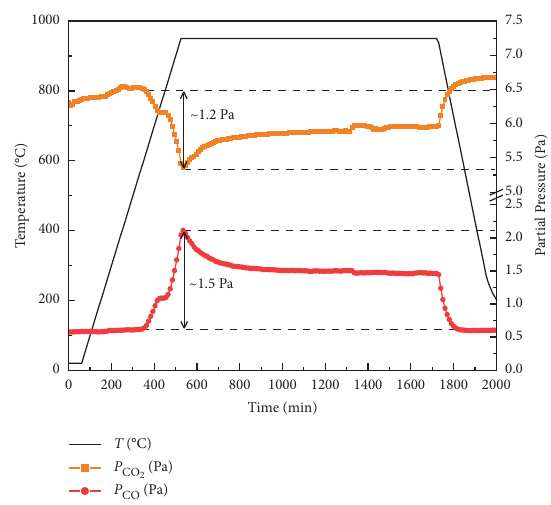
Figure 2: Evolution of the CO and CO temperature program as a function of